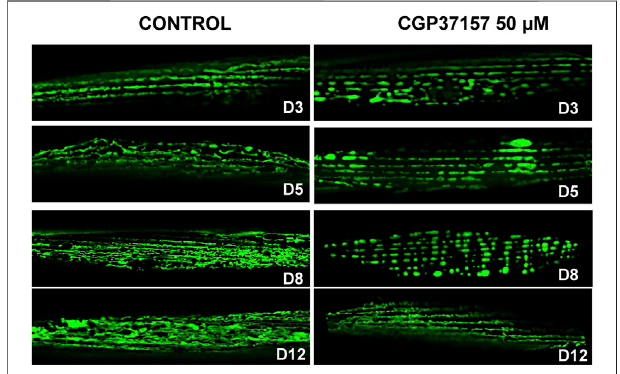
FIGURE 6 | Effect of CGP37157 on the mitochondrial structure in C. elegans body wall muscle during aging. SJ4103 worms, expressing GFP inside mitochondria of body wall muscle cells, were imaged by confocal microscopyat differentdays ofadult life, eithertreatedor not with50 µM CGP37157 since day 1 of adult